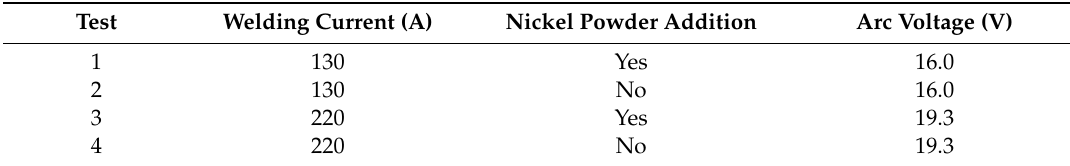
Table 4. Factorial design 2 k (preliminary